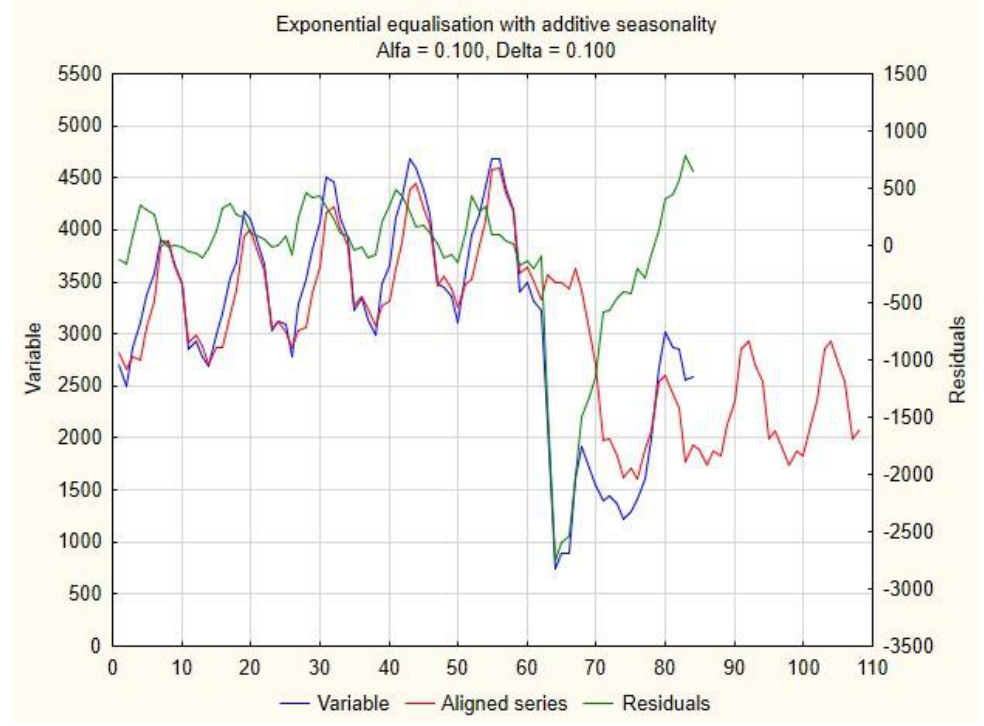
Figure 2. Number of passengers served (in persons). Source: own elaboration. Due to the features of the series, we decided to use the exponential smoothing method with additive seasonality. The results obtained with the use of Statistica 13.3 software are shown in Figure 3.